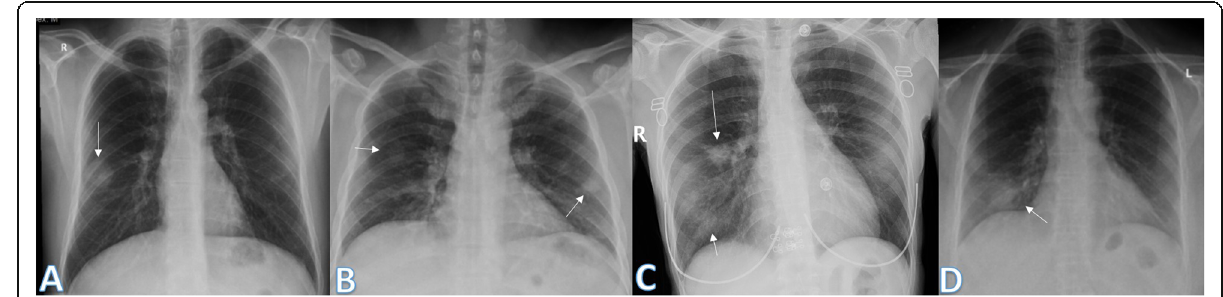
Fig. 9 Four different patients with positive COVID-19. a 32-year male was complaining of cough. Initial chest X-ray showed a well-defined solitary pulmonary nodule at the lateral aspect of the right middle lung zone (arrow). The total severity score was 1. b 49-year male was complaining of fever. Initial chest X-ray showed two small well-defined pulmonary nodules at both middle lung zones (arrows). The severity score was 1 for each lung, so TSS was 2. c 36-year female was complaining of sore throat. Initial chest X-ray showed right perihilar fairly defined pulmonary nodule (long arrow) and right lower zonal ill-defined ground glass opacity (short arrow). The total severity score was 2. d 52-year female patient presented with cough, showed